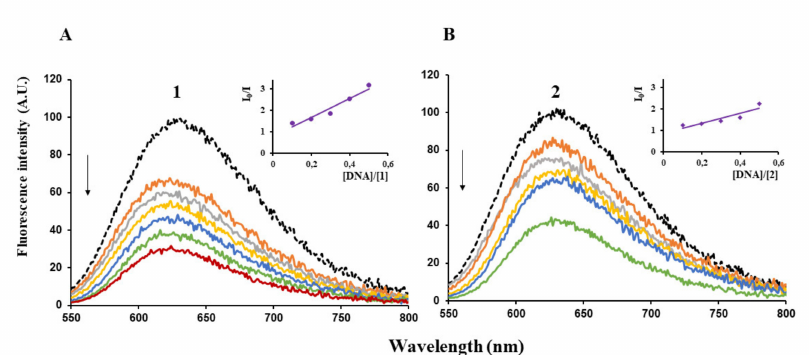
Figure 5. Emission spectra of λ -DNA / EB in Tris / HCl / NaCl bu ff er, pH = 8, in the absence (black curves) or in the presence of increasing concentrations of ( 1 ) ( A ) and ( 2 ) ( B ) (arrows indicate increase in [complex]. Insets: plots of emission intensity versus [DNA] / [Complex]. I 0 = fluorescence intensity in the absence of complex. I = fluorescence intensity in the presence of